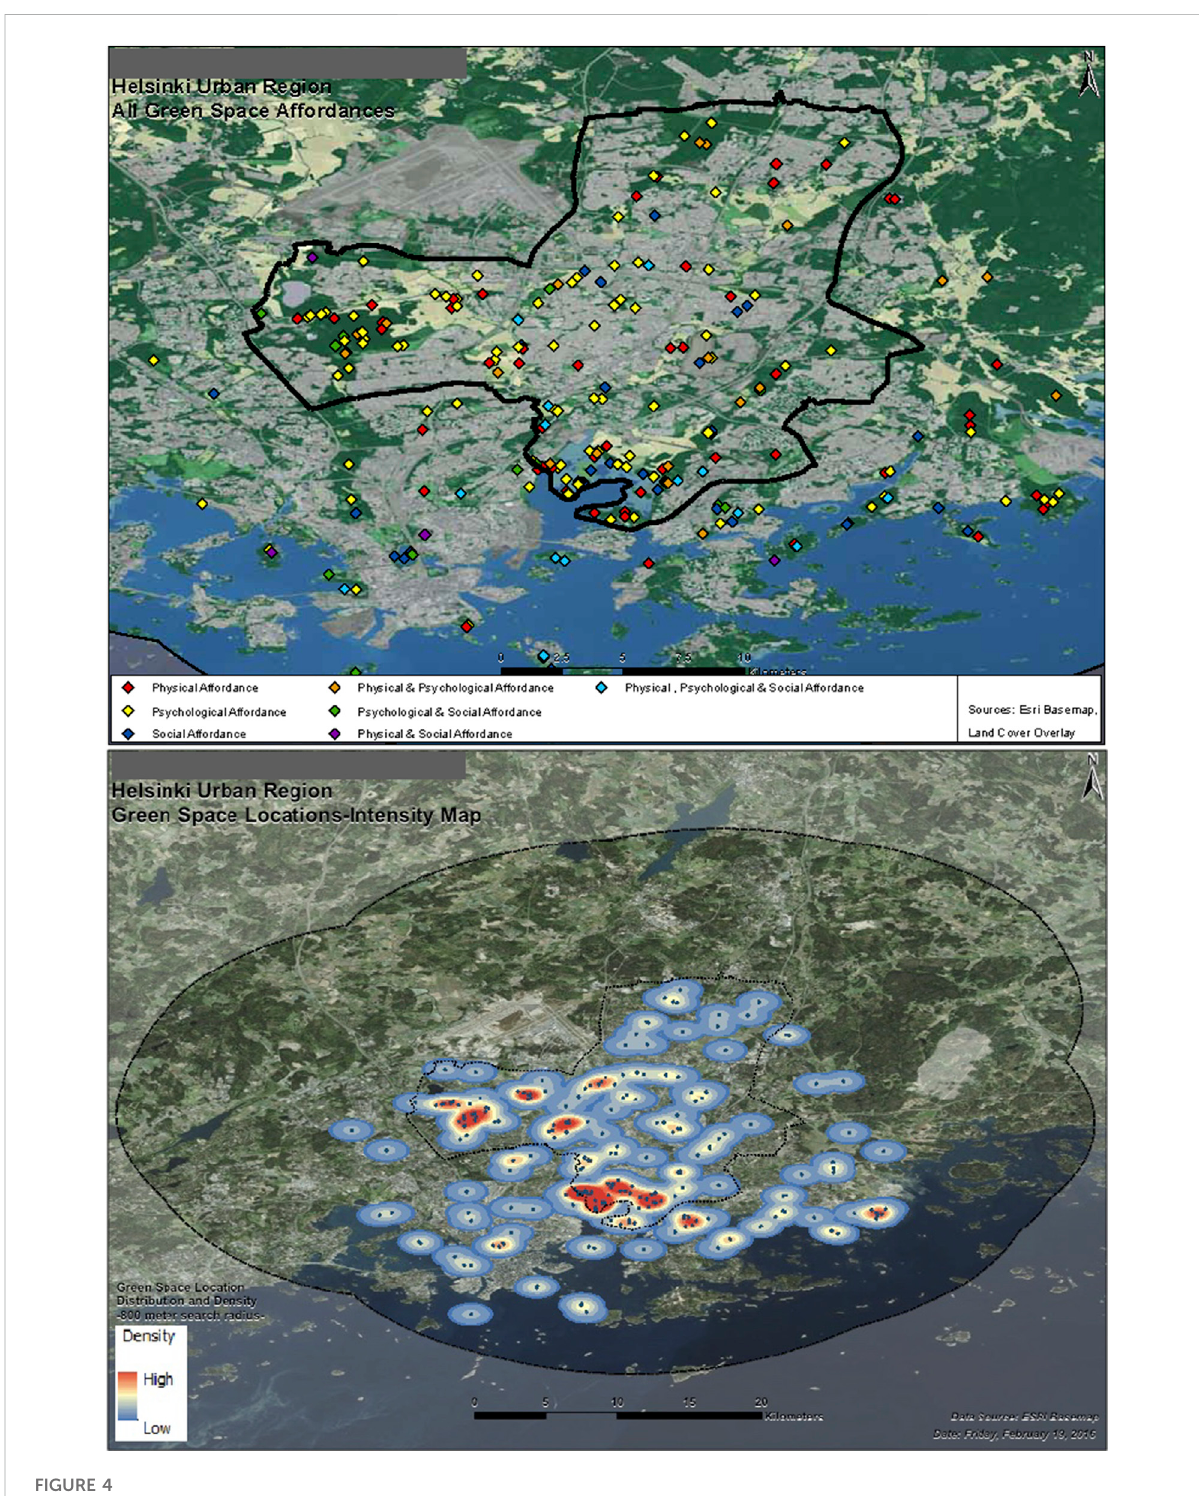
FIGURE 4 Human wellbeing affordance locations and intensity map. Source: